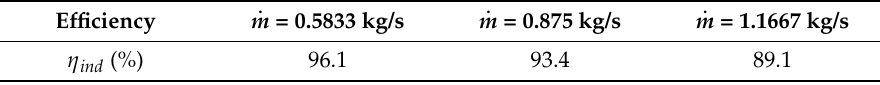
Table 4. Efficiency system for the second configuration varying the liquid flow